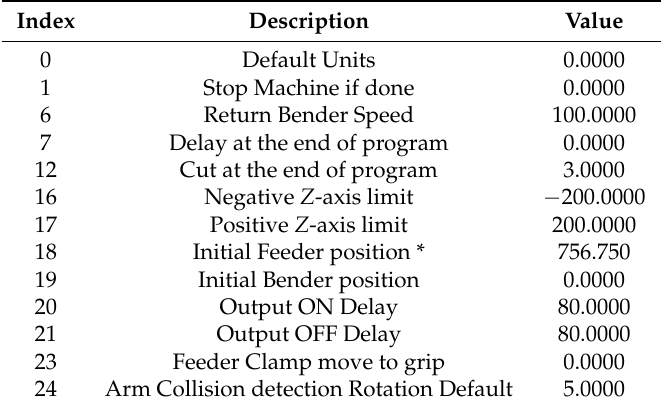
Table 3. Operating parameter values to operate the CNC bending machine for the Nuss bar.